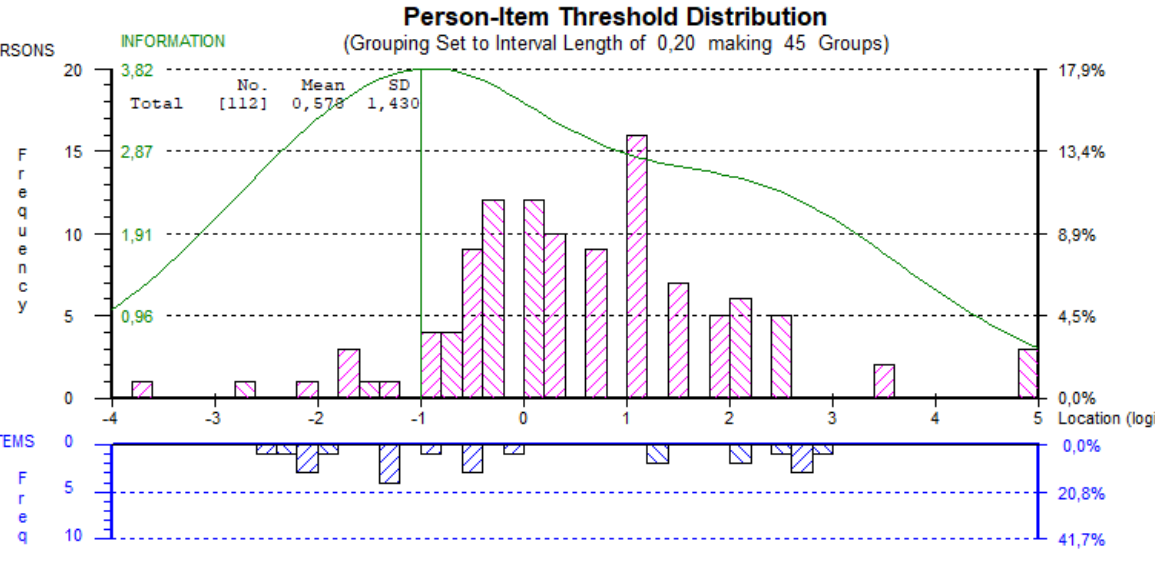
Figure 4. Person-item threshold histograms for the 12-item version. Upper histogram (pink bars) shows person measurements reflecting lower leniency with the Health Integrator app to the left, and higher leniency with the Health Integrator app to the right, that is, the most lenient persons are to the right. The lower histogram (blue bars) shows item threshold estimates reflecting lower quality demands to the left and higher quality demands to the right. This implies that it was easier to agree to statements at the lower end corresponding to negative experiences of using the mobile health (mHealth) app compared with the less easy items to agree with at the upper end, corresponding to lifestyle consequences of using the mHealth